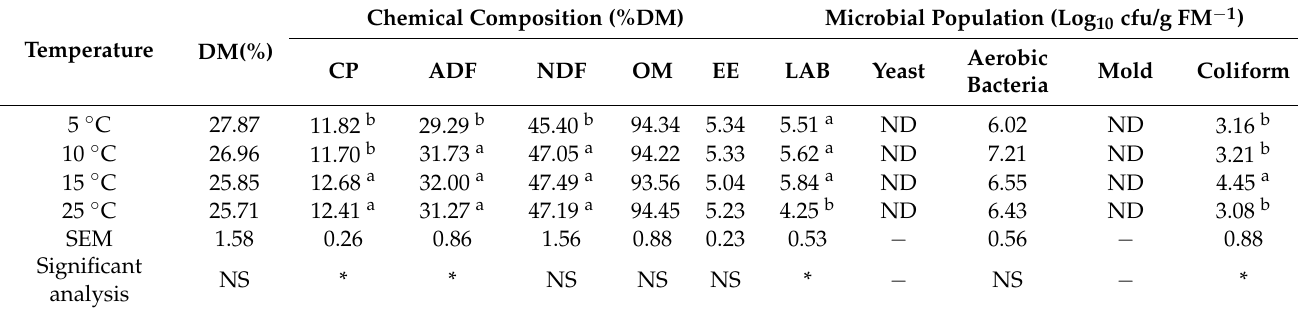
Table 2. Chemical composition and microbial population of oat silage after 60 days of ensiling.